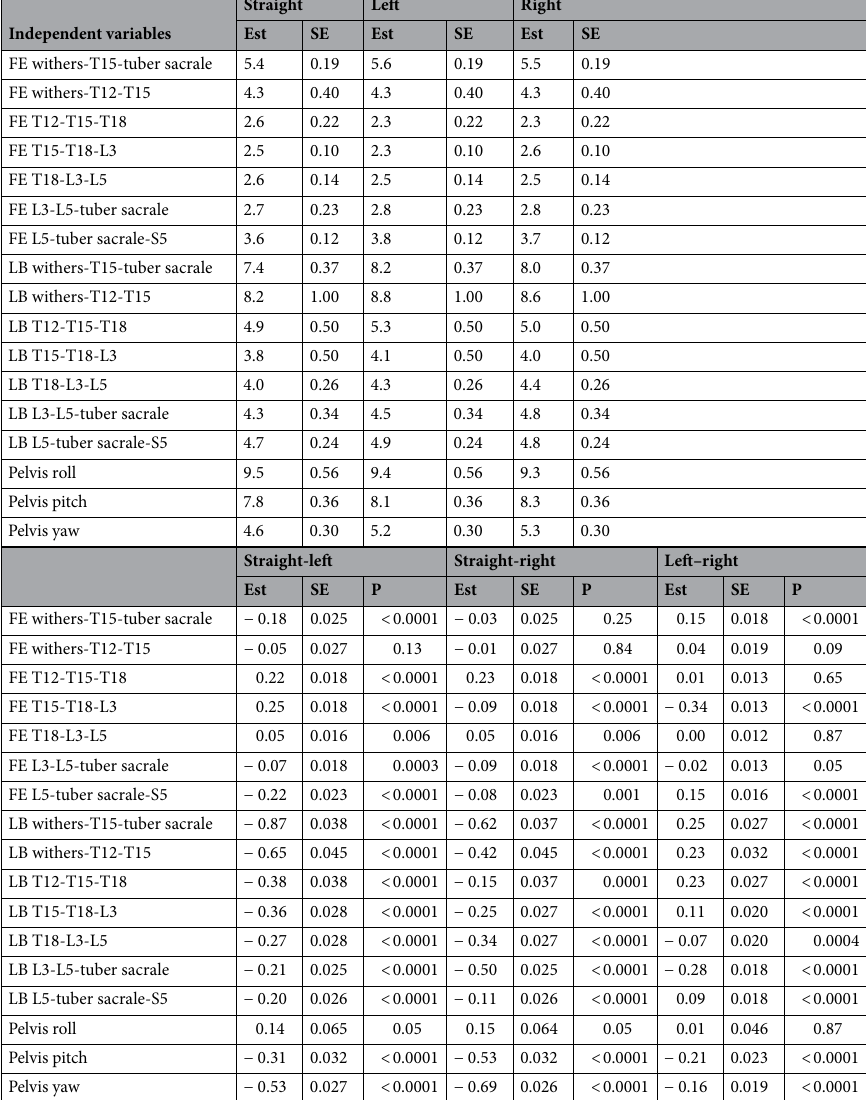
Table 2. Least square means estimates (Est) and standard errors (SE) by path, and estimated differences between paths including P-values (P), for stride range of motion (ROM) flexion–extension (FE) and lateral bending (LB) variables (all in degrees). Each model also contained a speed*path fixed effect (supplement 1) and included between 8055 and 8073 observations (strides) from 12